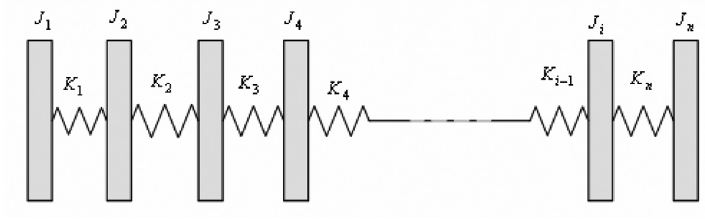
Fig. 1. Multi-segment lumped mass